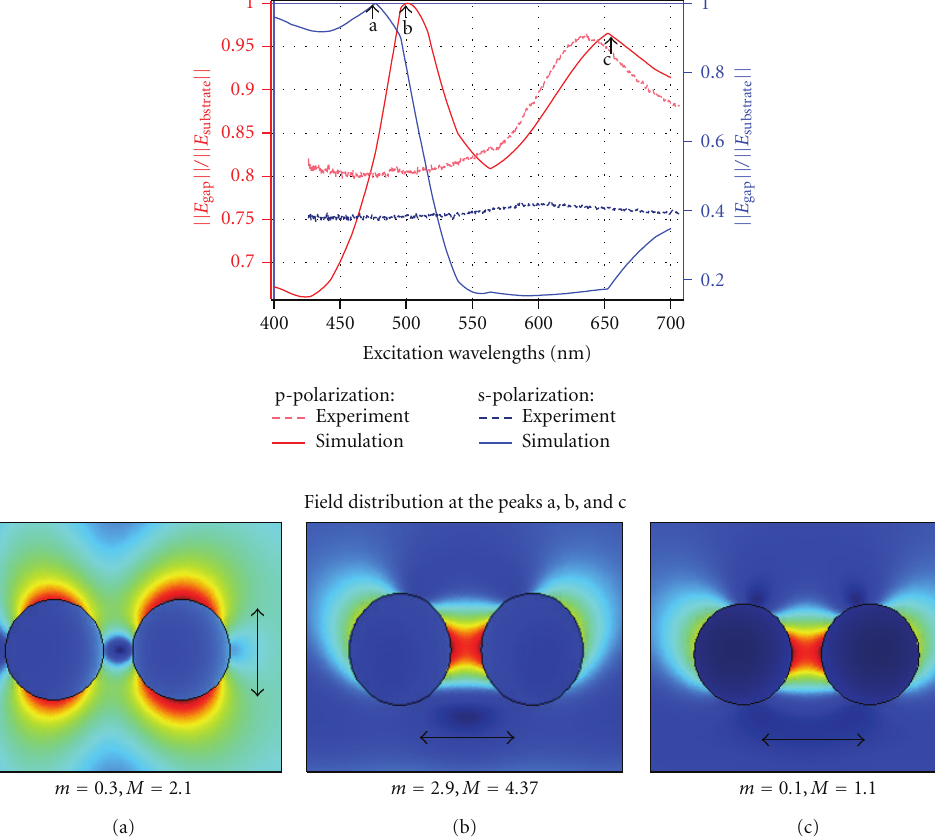
Figure 2: Theoretical and experimental spectra of the electric field and extinction for dimers (particles with 100 nm diameter) with 30 nm gap. The (a) to (b) labels indicate the excitation parameters where resonances occur. These are then used in the corresponding insets to display the field distribution under these excitation conditions. The insets (a) to (c) depict the total field fingerprint for each spectral peak (black arrows show the polarization state), to illustrate the resonances and local field enhancement around the